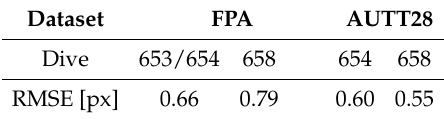
Table 2. RMS calibration errors (in pixels) measured as perpendicular distances between the projected laser beams and laser intersections with the scene for the two datasets and